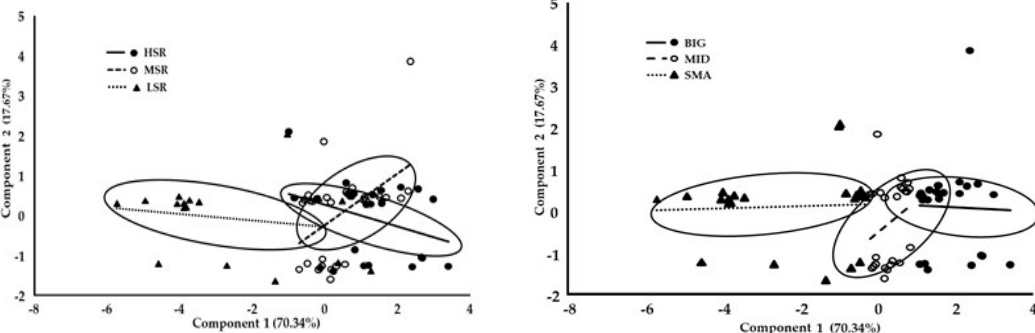
Figure 3. Principal components, the eigenvalues, and the proportional and cumulative variance based on morphometric traits in crossbred dairy goats; plots represent the eigenvalues across the six principal components ( Left panel ), and both proportional and accumulative variance across the six principal components ( Right panel ). Both panels are based on the eigenvectors and eigenvalues generated from correlation matrix among the morphometric values measured from crossbred dairy goats managed under intensive conditions ( n = 70). Note: more details were previously described in the main body of the text.